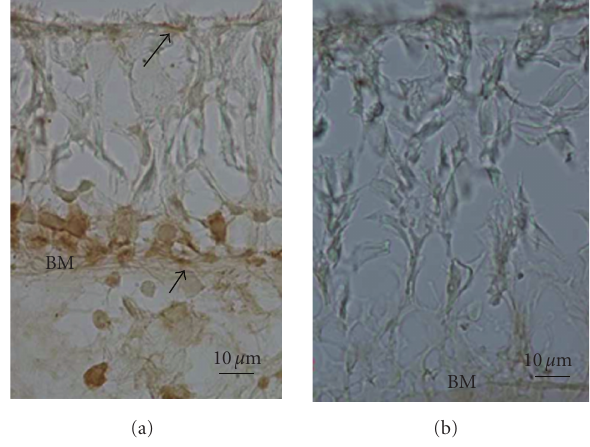
Figure 2: Light micrograph of NGAL-immunoposive cells in the bronchial epithelium. (a) NGAL-immunoreactivity in bronchial epithelial cell of control group. NGAL-immunopositivity weakly demonstrated in substantial number of cells vicinity to basement membrane (BM) (short arrow) and rarely in the luminal border of epithelial cell (long arrow). (b) Immunoreactivity intensity decreased at bronchial epithelial cell of chemical injured patients and no immunoreactions is seen throughout the section. Note that the thickness of epithelial cell layer in experimental group is higher than control group due to chemical injury. BMbasement